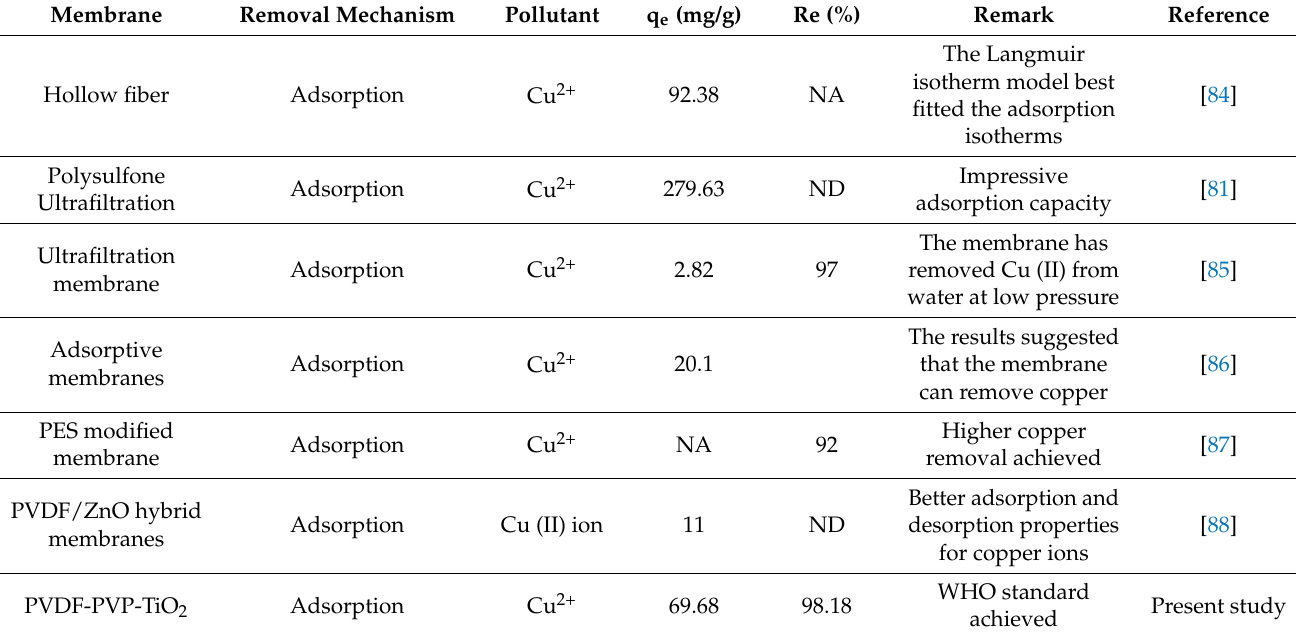
Table 2. Comparison of adsorptive removal of heavy metals by